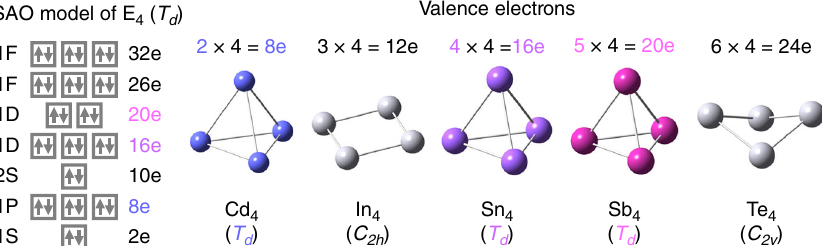
Fig. 3 Optimized structures of E 4 clusters with various valence electrons. The symmetry-adapted orbital (SAO)-based electronic con fi guration is also shown for reference